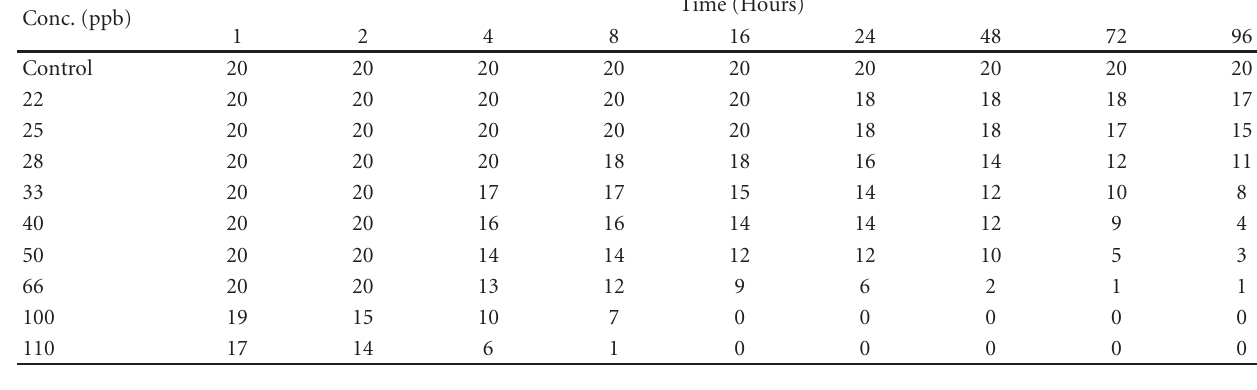
Table 1: Number of surviving Clarias gariepinus fingerlings treated with gammalin 20. Conc. (ppb)